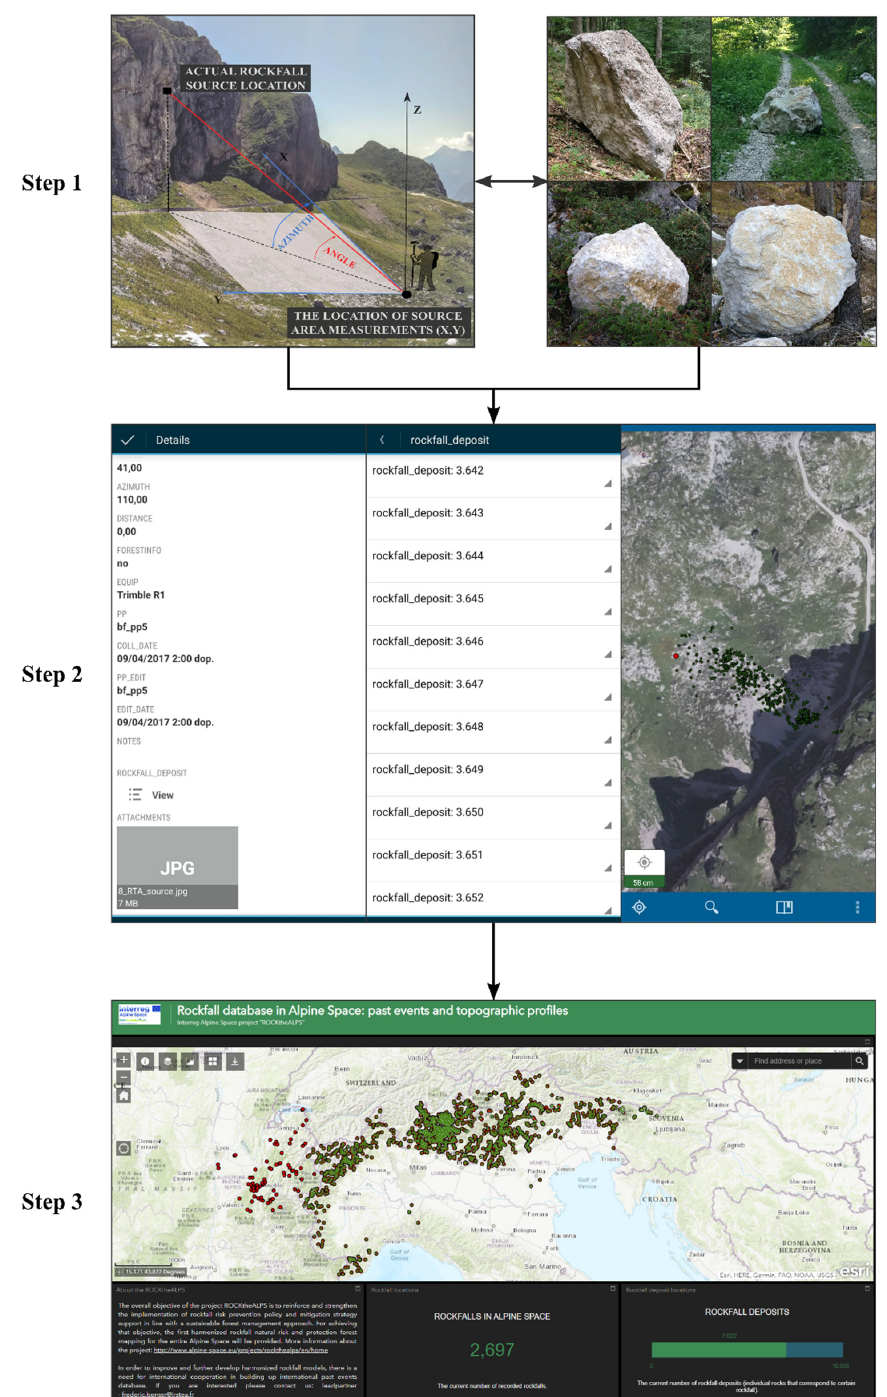
Figure 2. Logical representation of rockfall data collection: Step 1 — concept of defining rockfall source area and deposit areas in the field; Step 2 — mobile application Collector for ArcGIS interface (left — entering data for source area, middle — the list of recorded rockfall deposits, right — the collected features presented on the Web Map, red dot- source point, green points — deposit points); Step 3 — data that are being collected with the Collector for ArcGIS are being stored to the cloud-based database on the ArcGIS Online Server. With that they are also synchronised with existing web rockfall database (after the field work). Collected data are then directly visualised in the WebGIS Platform as a Web Map that enables displaying, analysing and querying of stored data in the cloud.